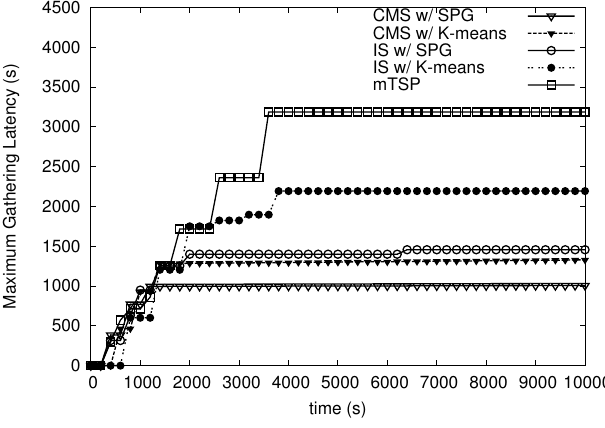
Figure 11. Maximum data-gathering latency over time.